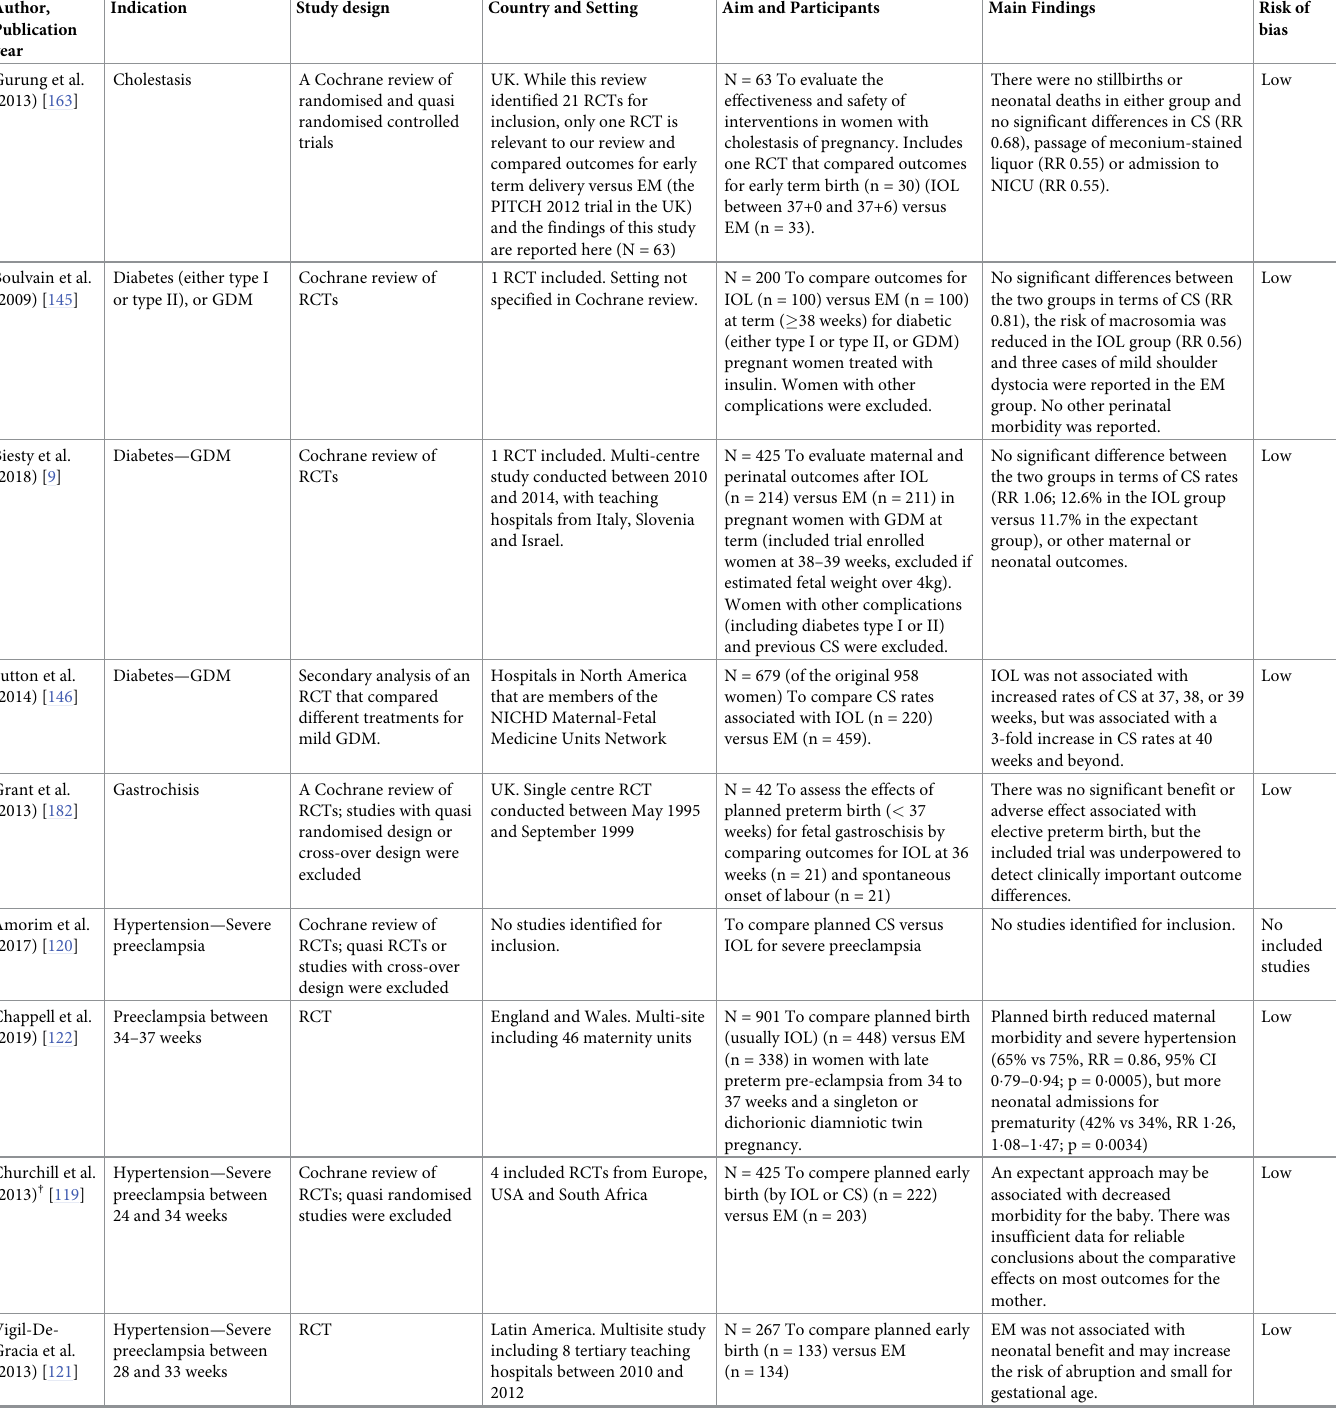
Table 1. Included randomised controlled trials and meta-analyses of